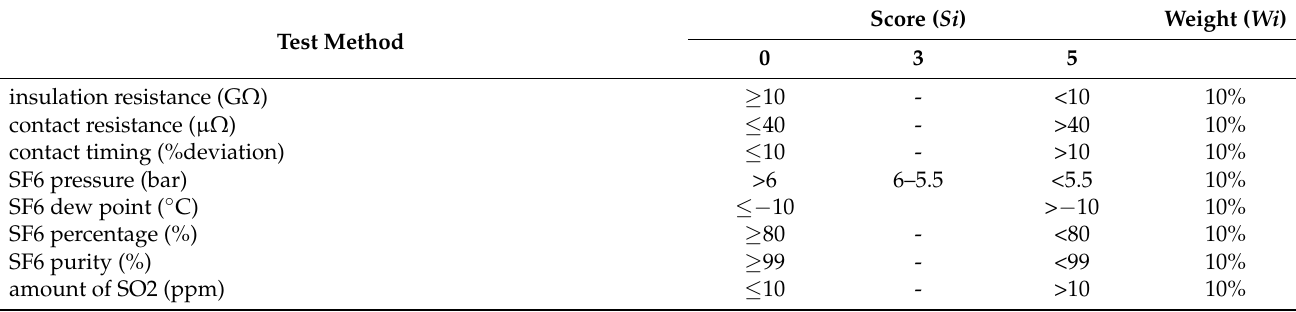
Table 2. Weighting–scoring method for the condition assessment of